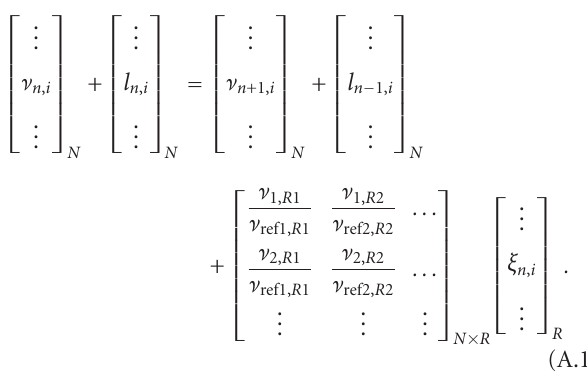
profile curves well approximate the simulated profiles in the lower part of the column but show deviation in the upper part because the simulated distillate composition is a little bit di ff erent from that specified in the feasibility calculations.